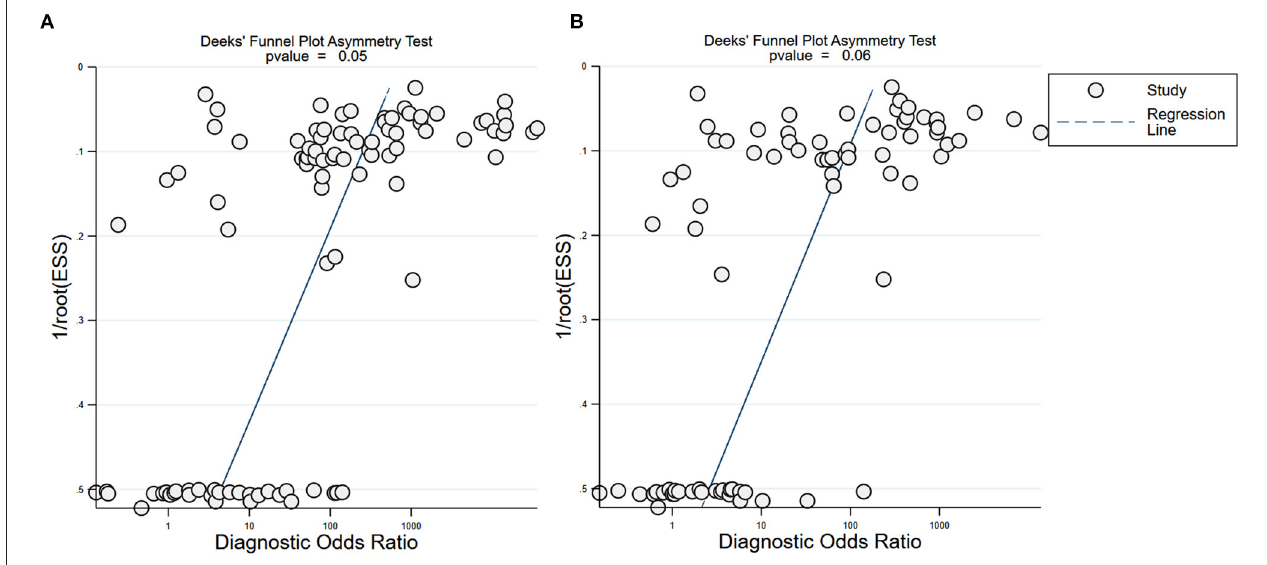
FIGURE 5 | Deeks’ funnel plot for IgG and IgM. Deeks’ funnel plot to assess publication bias for IgG (A) and IgM (B) . Plots show study size as a function of effect size for studies included in the meta-analysis. The dots represent each study.